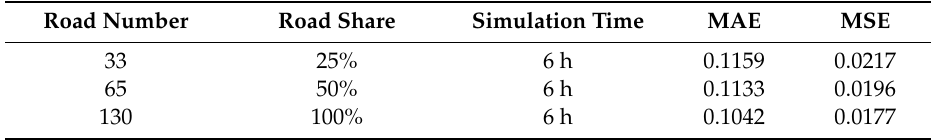
Table 6. The influence of the number of roads in the model input data on the prediction results.